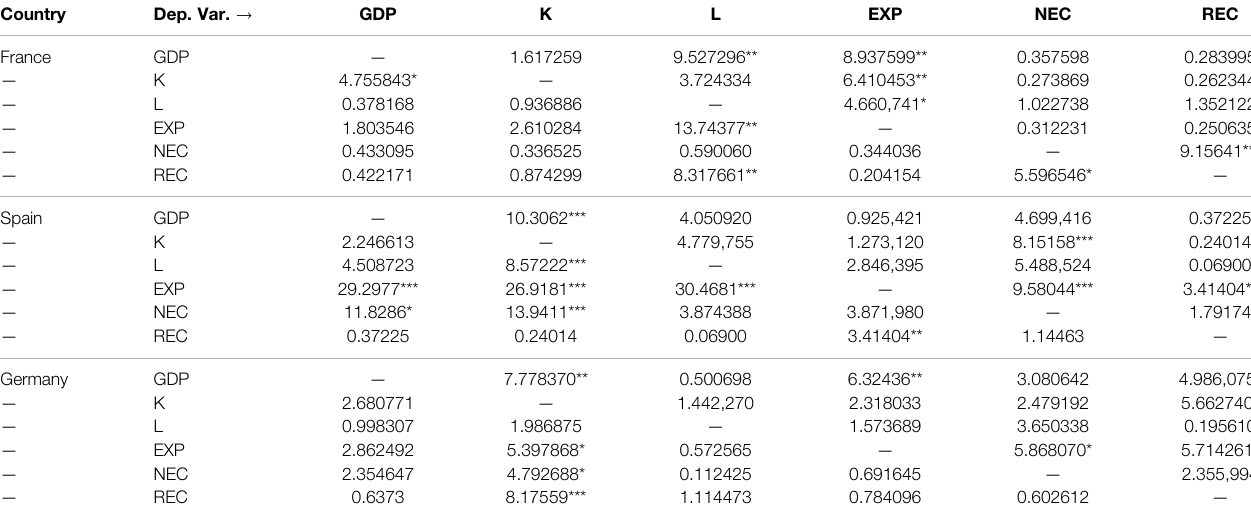
TABLE 12 | Results of the Toda-Yamamoto causality (1995) test. Country Dep. Var. →